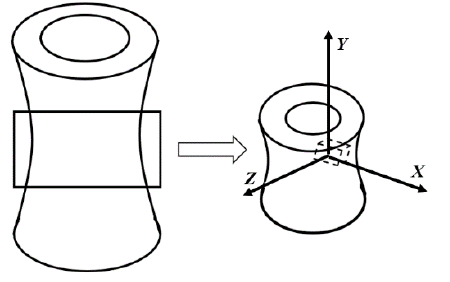
Figure 1. Radial, axial and tangential directions in the studied long bone.